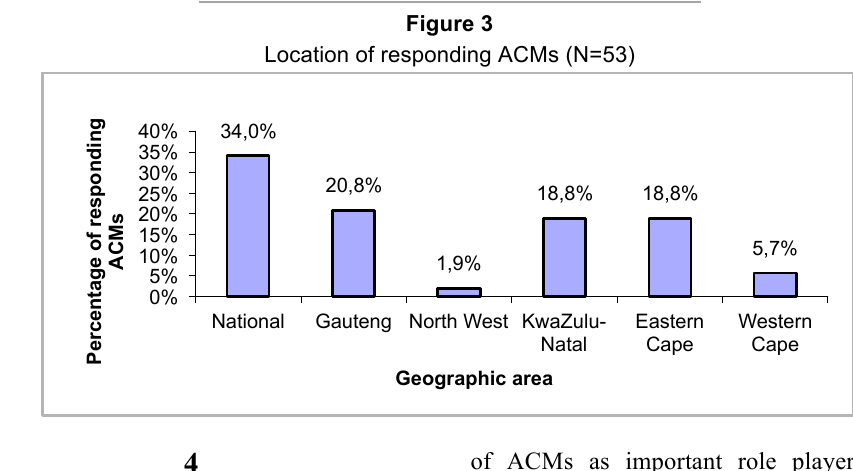
Location of responding ACMs